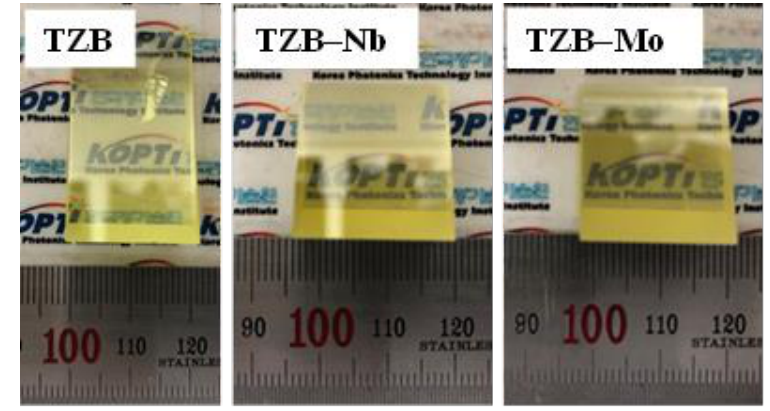
Figure 1. Photographs of indigenously developed TeO 2 -ZnO-BaO TZB series prism samples.